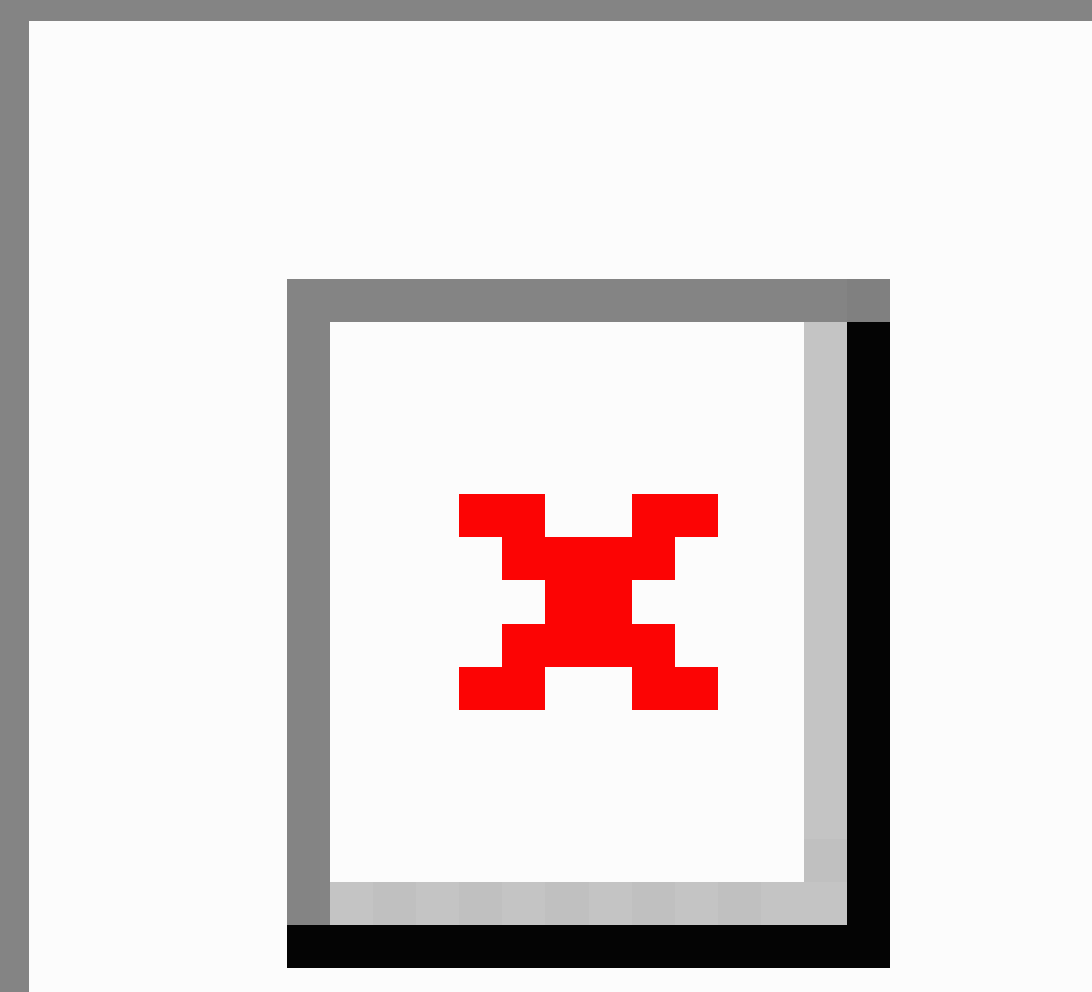
Redman et alJMIR MHEALTH AND